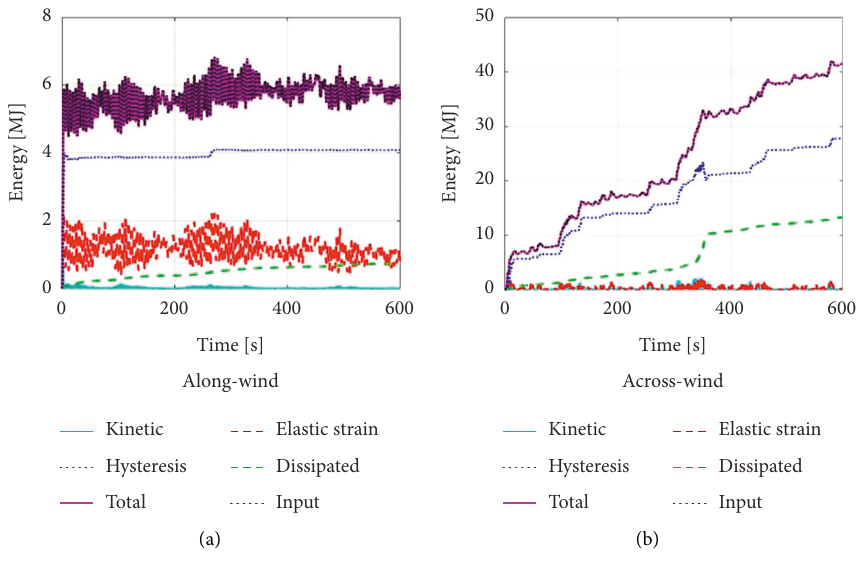
Figure 26: Energy balance for the nonlinear time history analysis H/sqrt(BD) � 8.